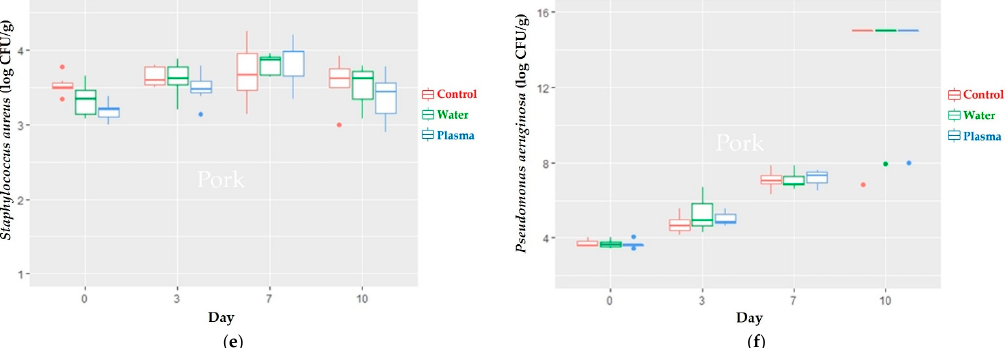
Figure 2. Microbial loads of ( a ) S. Enteritidis, ( b ) S. Typhimurium, ( c ) E. coli , ( d ) C. jejuni , ( e ) S. aureus , and ( f ) P. aeruginosa of pork samples at day 0 of the experiment and after being stored at 4–6 °C for 10 days ( p ≤ 0.05).